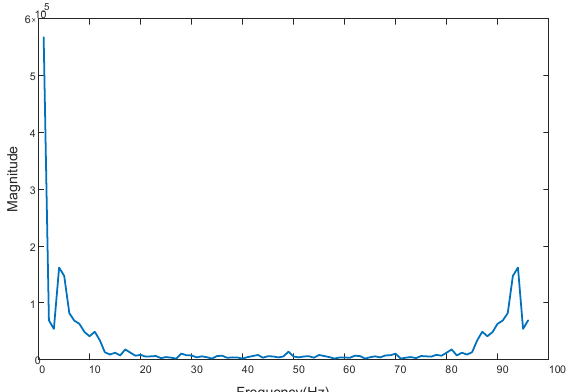
Figure 6. The output signal of the first detector in the frequency domain (annular regime, void fraction = 5%).